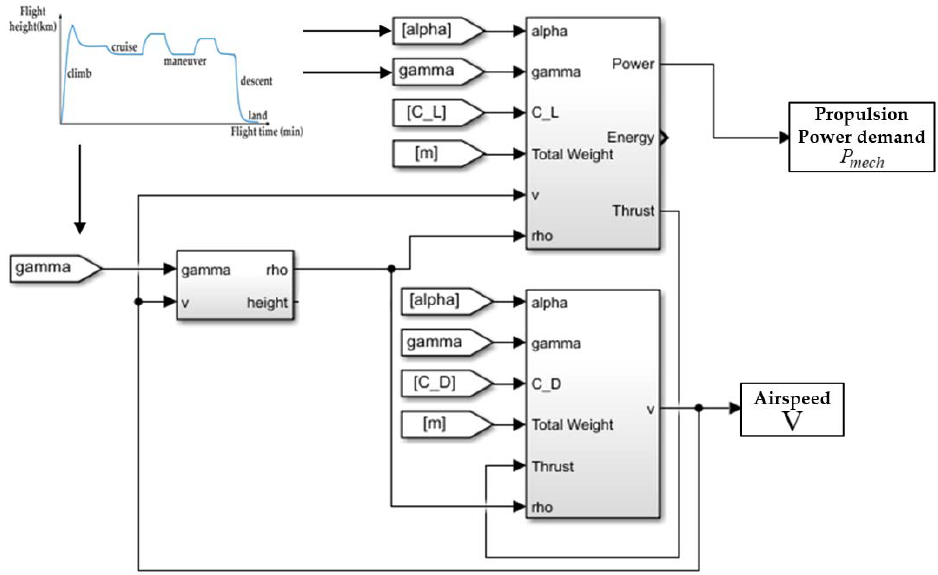
Figure 4. The method of obtaining the propulsion power demand of the UAV.